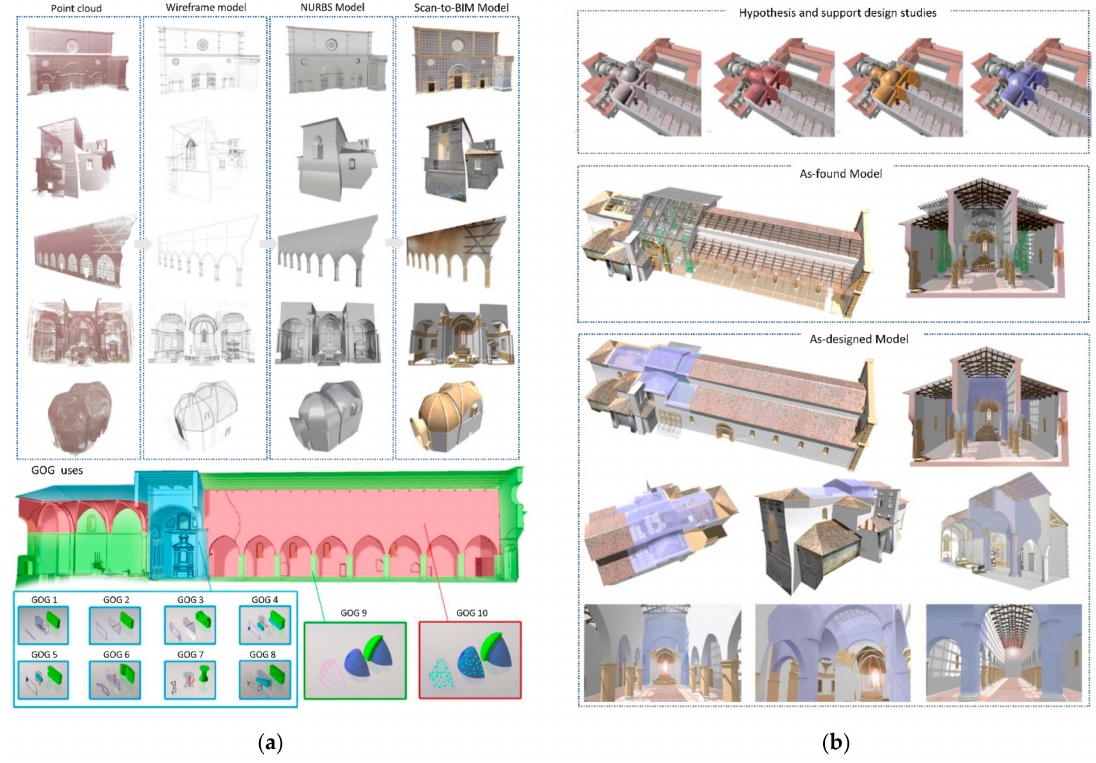
Figure 9. HBIM model of Basilica of Collemaggio is based on ( a ) multiple GOGs that enabled ( b ) interactive configurations for the preservation